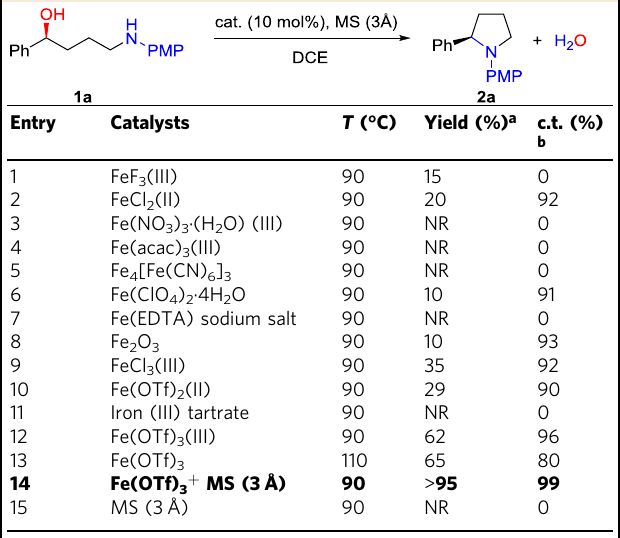
Table 1 Selected optimization of the reaction conditions for benzylic alcohols